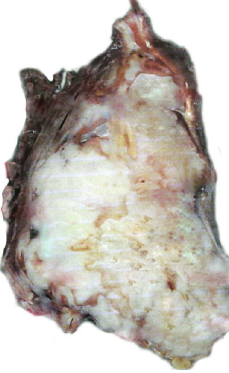
Figure 2: Macroscopic picture of leiomyosarcoma of vascular origin.